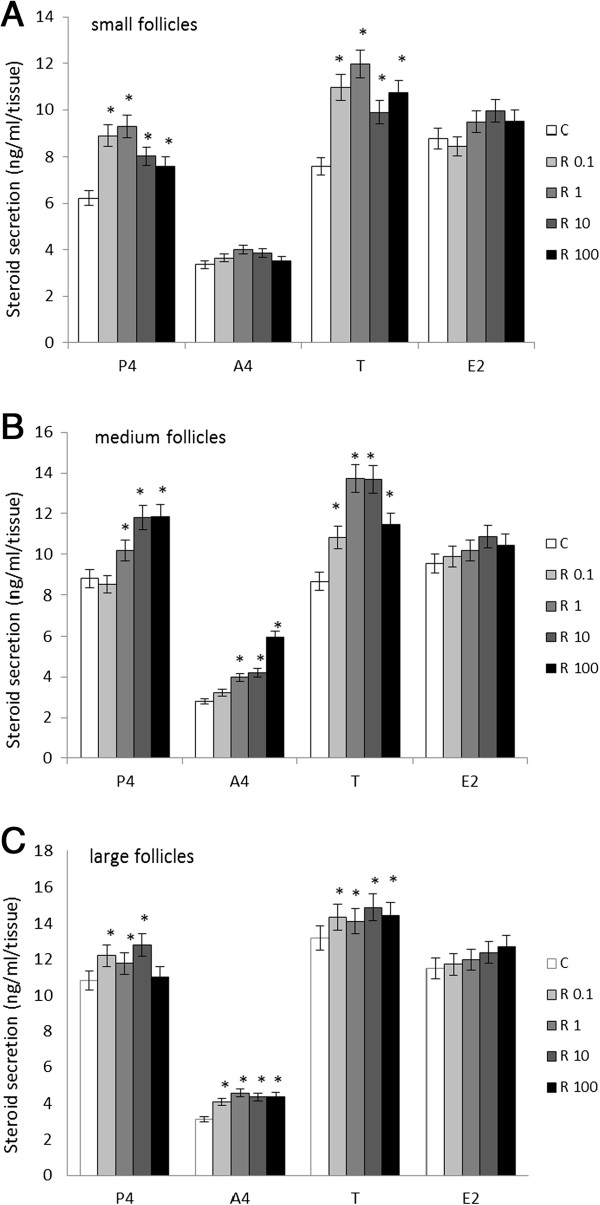
Effects of recombinant human resistin (0.1, 1, 10, and 100 ng/ml) on steroid hormone (i.e., progesterone [P4], androstendione [A4], testosterone [T], and estradiol [E2]) secretion in culture medium from A) small, B) medium and C) large ovarian follicles. ELISA experiments were performed three independent times. In each experiment six ovaries from three different animals were selected. Data were plotted as mean±S.E.M. Different letters indicate statistically significant differences among groups (P < 0.05).